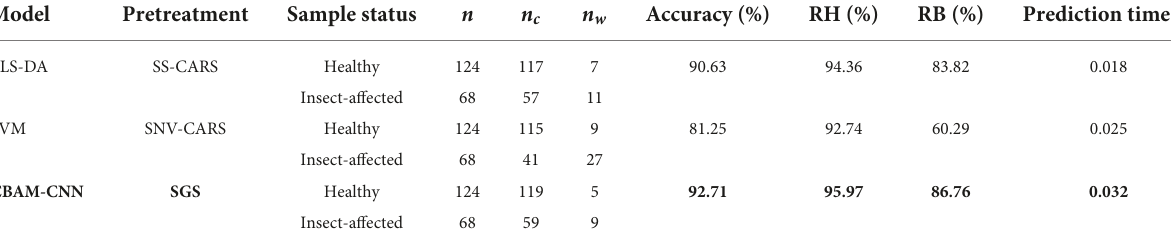
TABLE 5 Classification results of the validation set samples by PLS-DA, SVM, and CBAM-CNN models.